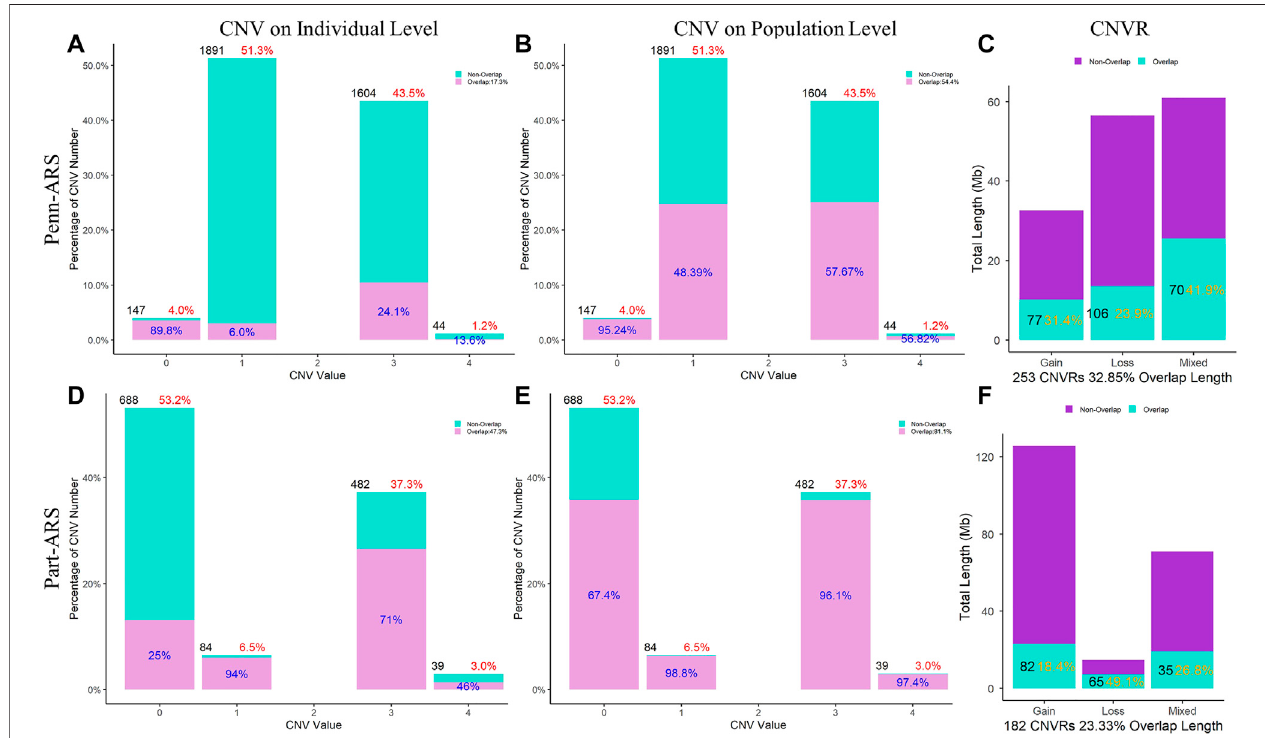
FIGURE 5 | Comparison of CNVs and CNVRs between the Penn-ARS and Part-ARS results. (A) and (D) are the CNVs comparison results on individual levels. (B) and (E) are the CNVs comparison results on population level. The percentage in red indicates the proportion of the number of CNVs with different states to the total number ofCNVs. The percentage in blue indicates the proportion of the number of overlapping CNVs to each CNV state group. (C) and (F) are the CNVRs comparison. The percentage in orange represents the proportions of overlapping length of CNVRs to the total length of each type